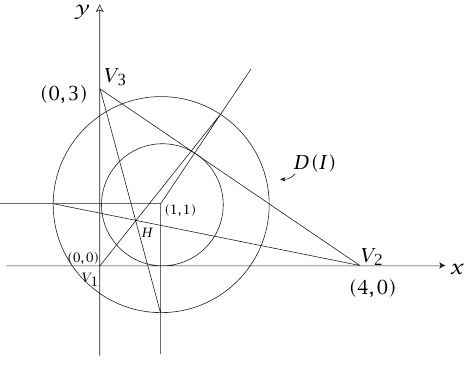
Figure 8 . The 3-4-5 right triangle located in the Cartesian